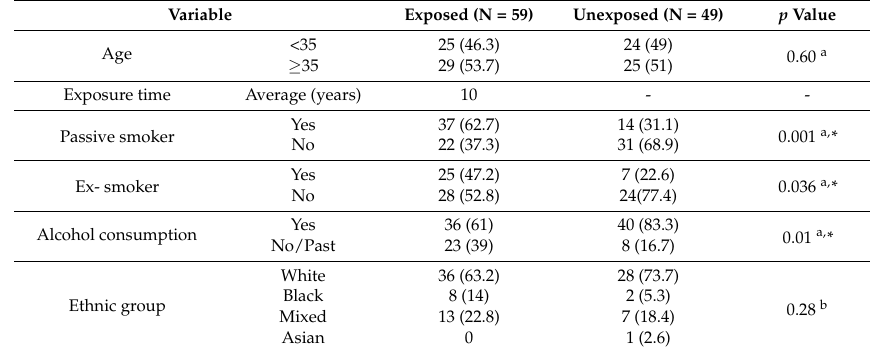
Table 1. Socio-demographic characteristic of participants from collected group (Exposed ×